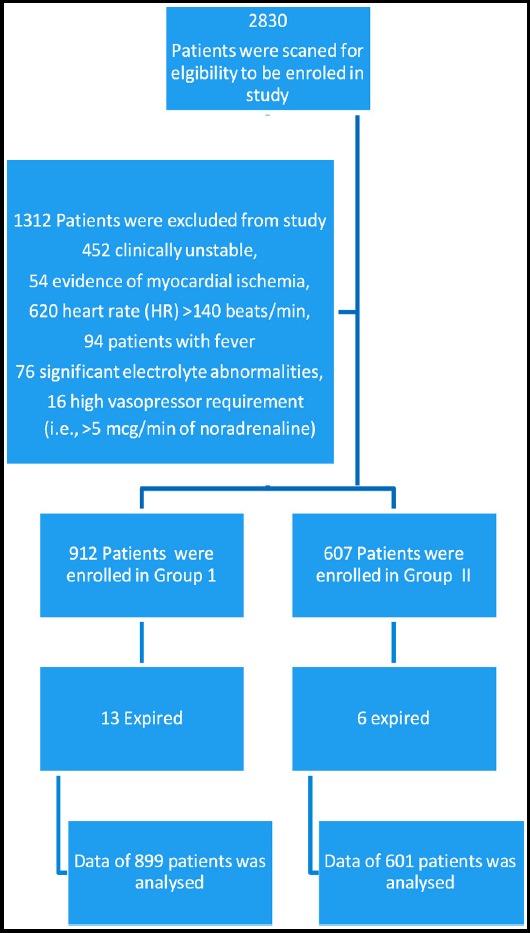
Flow Sheet of Study Patients.